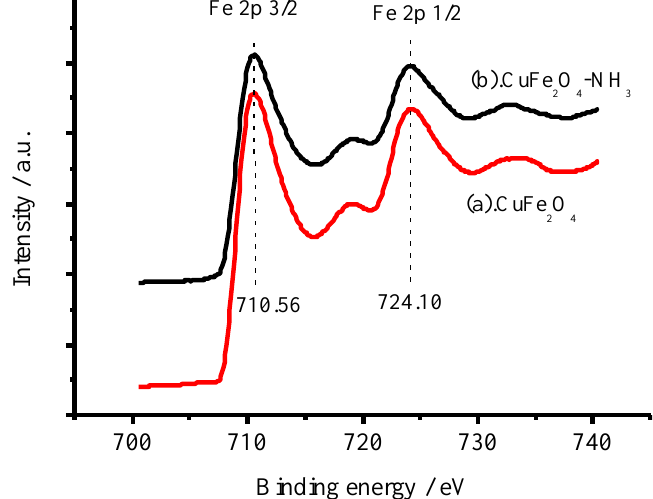
Figure 16. High-resolution XPS spectra of Fe 2p in the CuFe 2 O 4 sample before ( a ) and after ( b ) adsorbing ammonia.